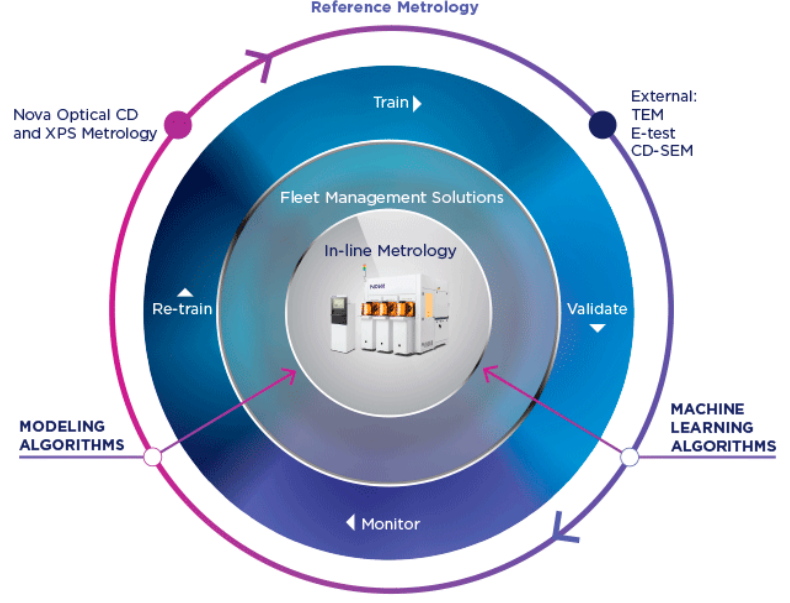
Figure 71. An image of NOVAFit™ applications for advanced nano-scale measurements [447].